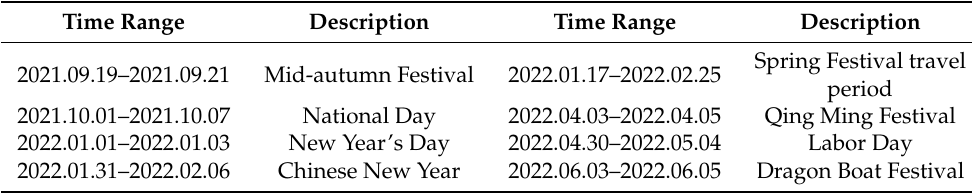
Figure 5. The temporal heterogeneity of different intercity mobility structures in the GBA. ( a ) The temporal heterogeneity of flow-in structure. ( b ) The temporal heterogeneity of flow-out structure. In conclusion, the daily stability of the intercity mobility structure differs during dif- Table 4. Descriptions of different holiday